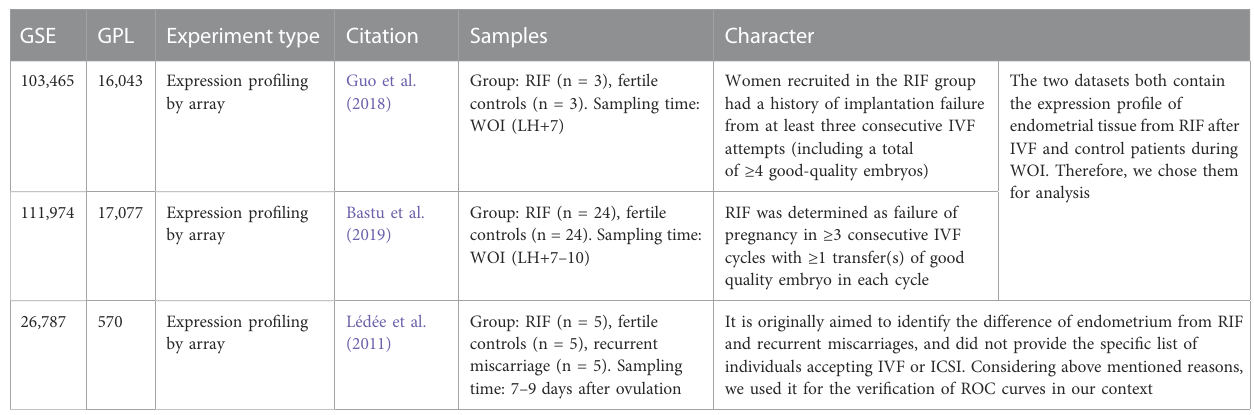
TABLE 1 Characteristics of the three GEO datasets